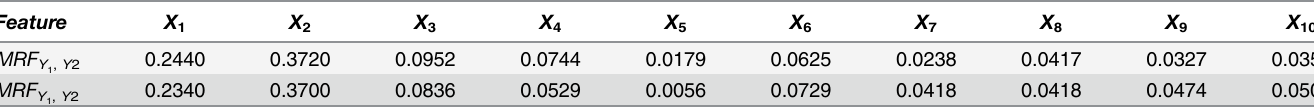
and VMRF Y 1 , Y 2 1 , Y 2